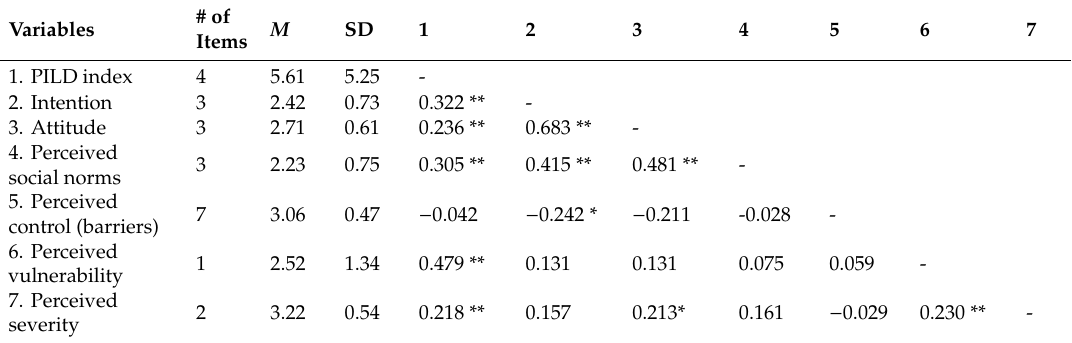
Table 4. Means, standard deviations, and correlations between the theory of planned behavior (TPB) variables, perceived vulnerability, and perceived